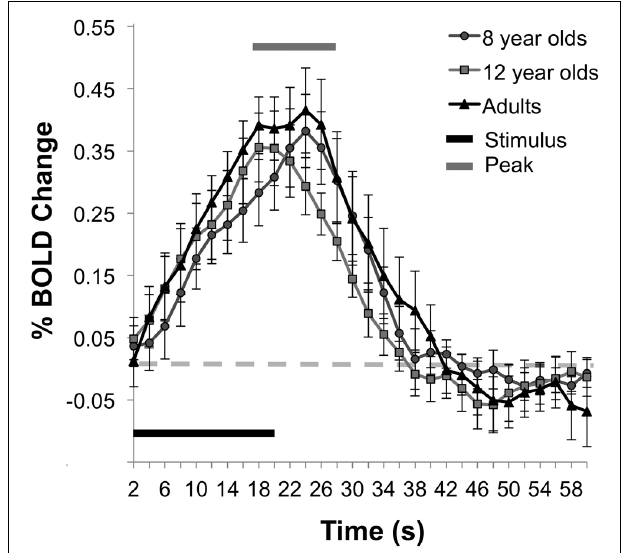
FIGURE 5 | BOLD percent signal change during activity. The mean time series of the BOLD responses show comparability in the magnitude of the BOLD response across the age groups.